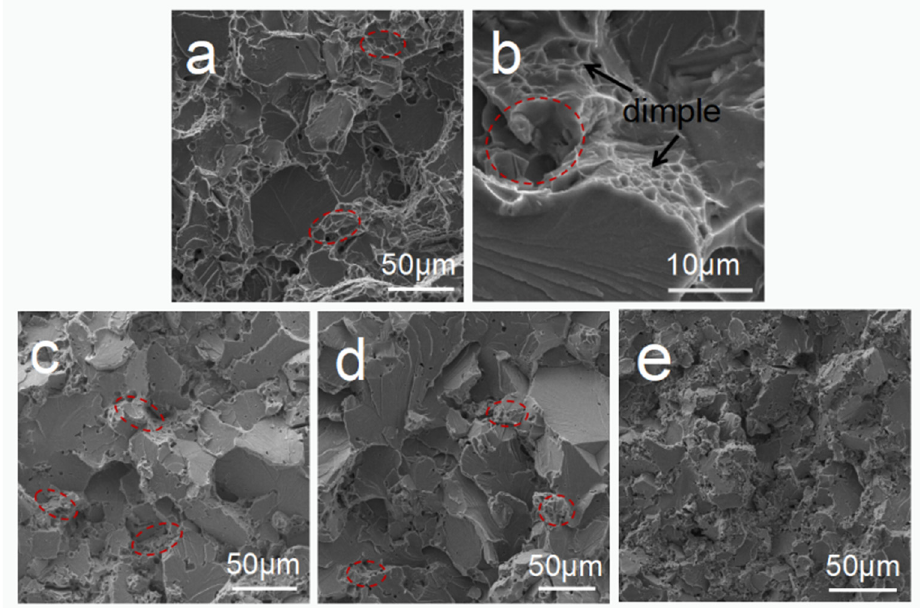
Figure 10. SEM imaging of the tensile fracture surface of Ti-30Mo-0.5TiC-xZr alloys tested at room temperature: ( a ) T0, ( b ) high magnification of T0, ( c ) T4Z, ( d ) T8Z, and ( e ) T12Z.